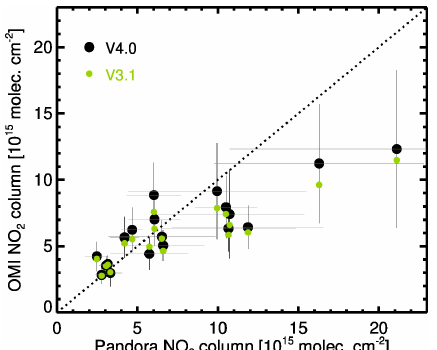
Figure 14. The scatter plot of Pandora versus OMI V4.0 (black) and V3.1 (green) average total column NO 2 for 18 Pandora sites. The vertical and horizontal lines represent the standard deviations for Pandora and OMI, respectively. The dotted line represents the 1 : 1